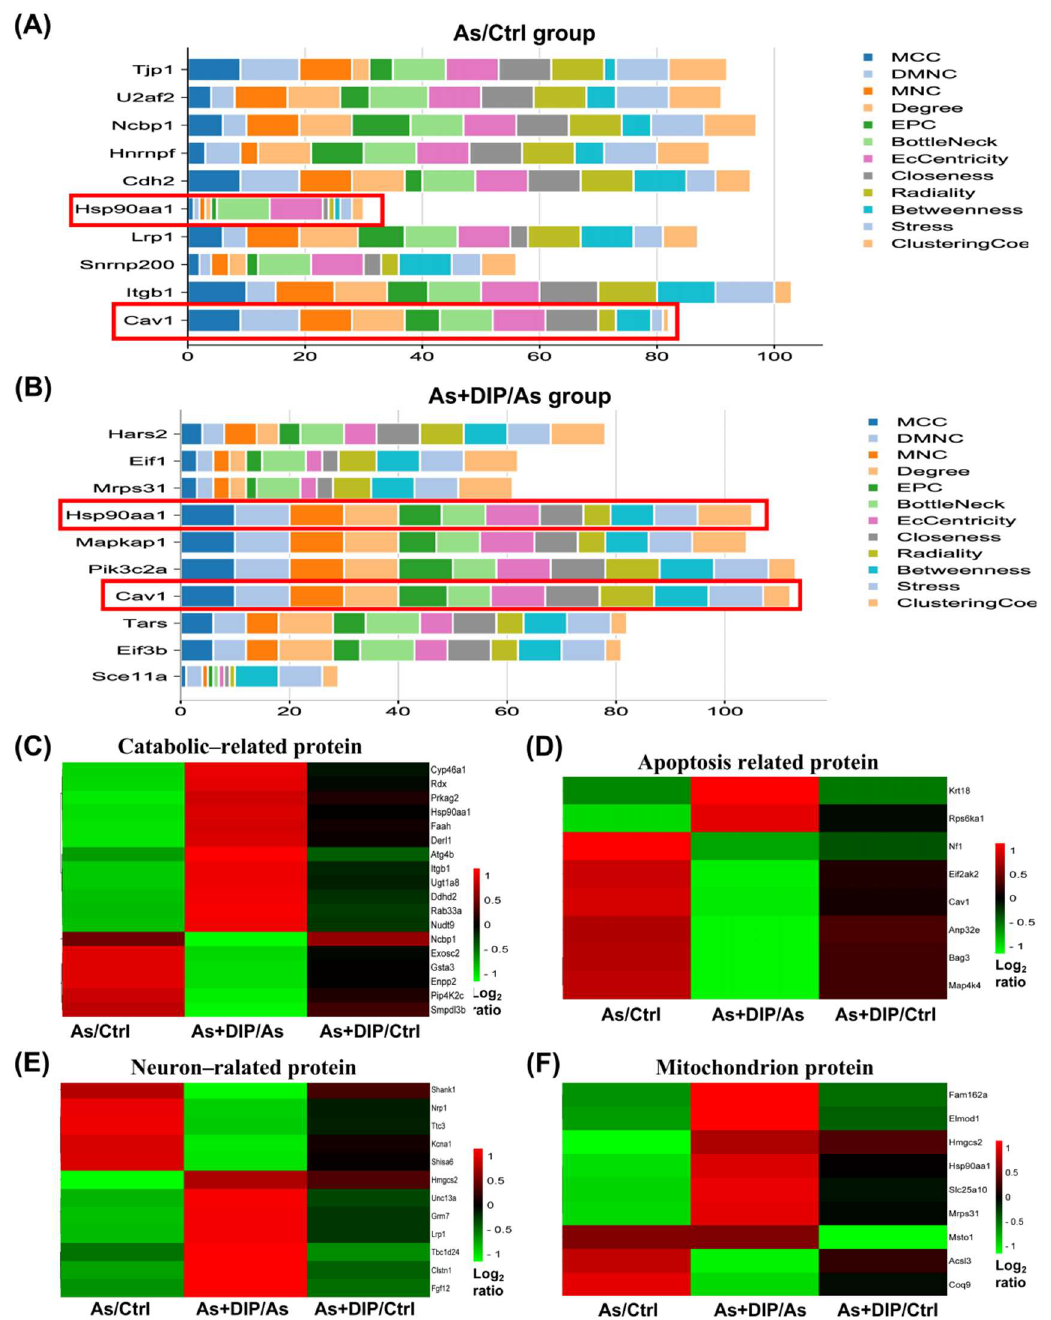
Figure 8. Hub gene and cluster analysis of the differentially expressed proteins in the key pathways in different groups. ( A ) The horizontal stack bar charts the top ten hub genes associated with the As/Ctrl group based on 12 hybrid algorithms. ( B ) The horizontal stack bar charts the top ten hub genes associated with the DIP + As/As group based on 12 hybrid algorithms. ( C ) Cluster analysis of catabolic-related proteins. ( D ) Cluster analysis of apoptosis-related proteins. ( E ) Cluster analysis of neuron-related proteins. ( F ) Cluster analysis of mitochondrial proteins.